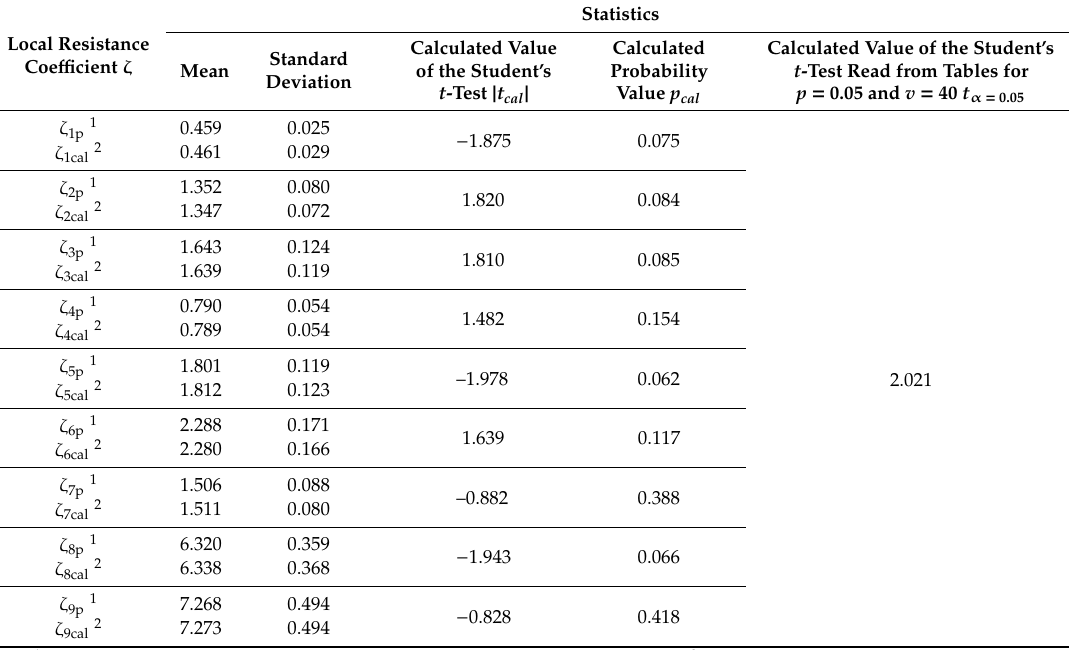
Table 4. Results of calculations of the statistics using Student’s t -test. Di ff erences of the mean values were significant with the probability p <